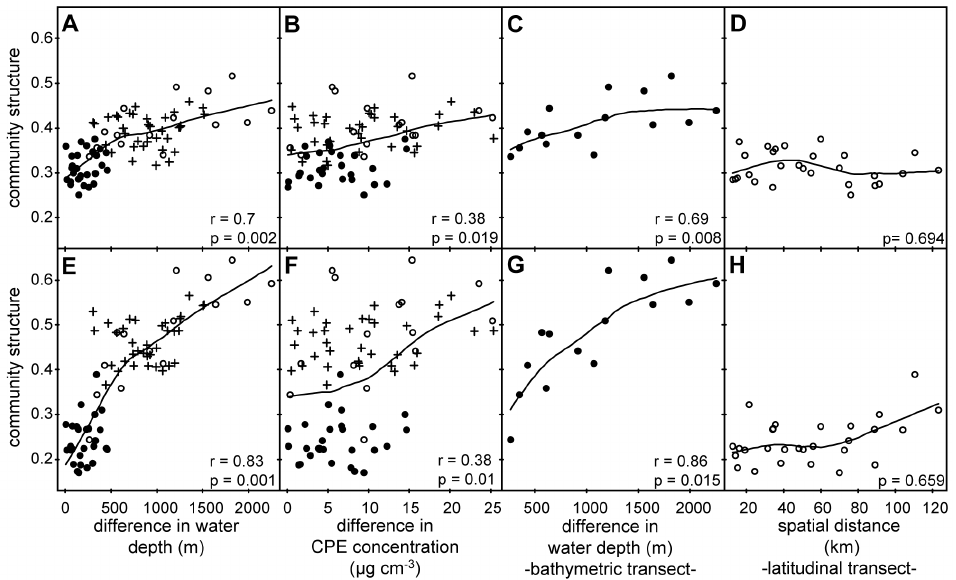
Figure 4. Changes in bacterial community structure with water depth and CPE concentrations and along spatial distance for the two transects. The plots A, B, C and D are based on MPTS data, plots in E, F, G and H are based on ARISA data. Filled circles indicate comparisons of samples from the latitudinal transect, open circles indicate comparisons of samples from the bathymetric transect, crosses indicate comparisons across transects. C, D, G and H are based on a subset of 6 and 8 samples for the bathymetric and latitudinal transects, respectively. Mantel tests were used to assess the significance of Spearman’s correlation coefficients (r) based on 1000 permutations.